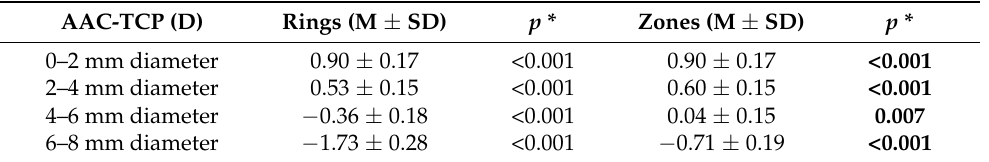
Note: D = diopter; M = mean; SD = standard deviation. * Paired two-tailed t -test. Statistically significant values (at the 5% level) are in